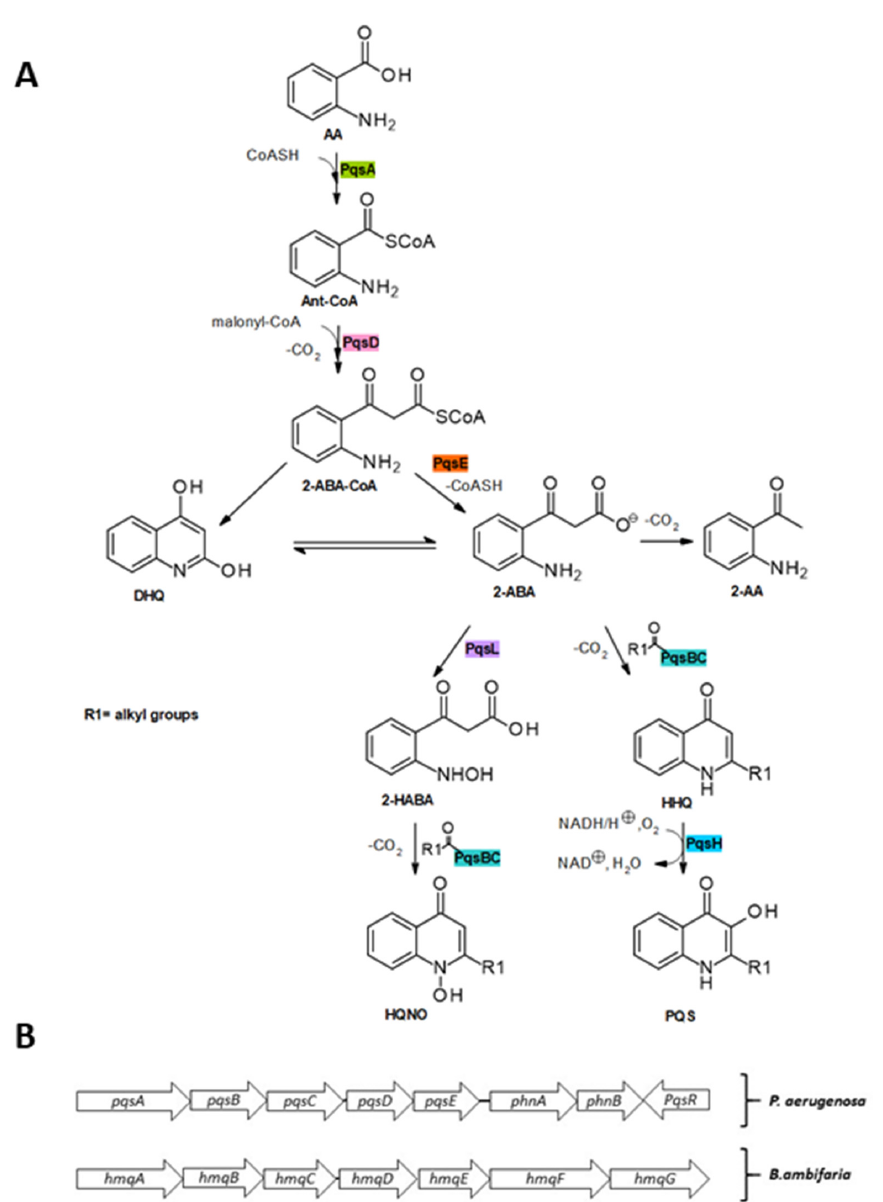
Figure 4. Biosynthesis of 4-quinolones of Pseudomonas aeruginosa . ( A ) PqsA catalyzes the activation of